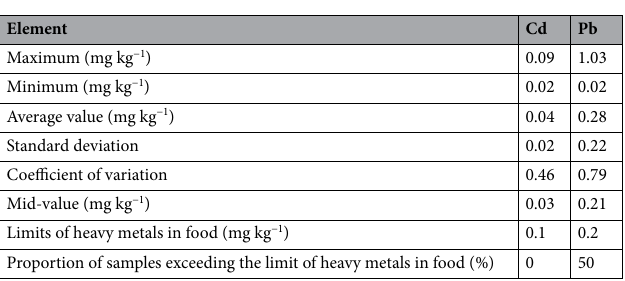
Table 6. Statistics of Cd and Pb content in wheat